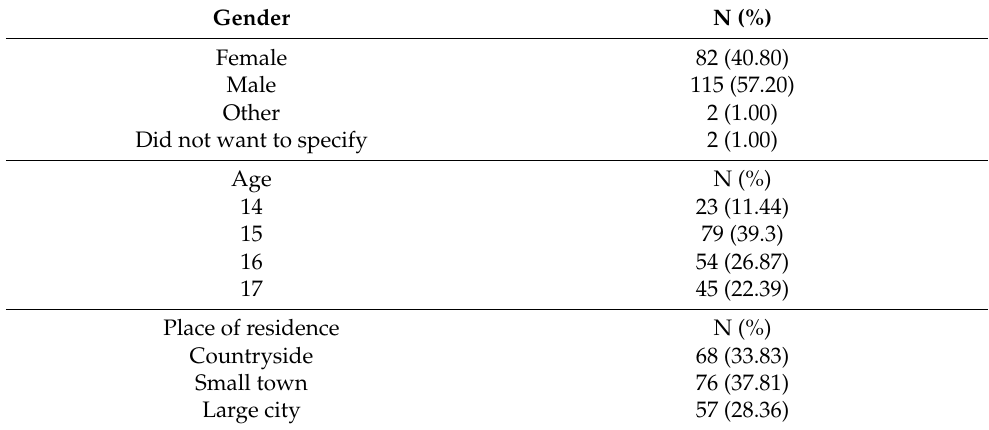
Table 1. Socio-demographic characteristics of the